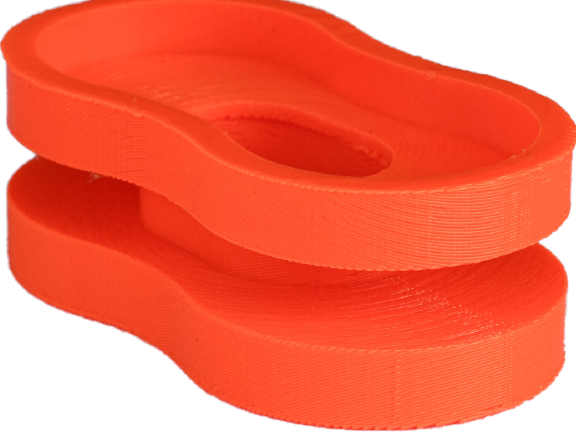
Figure 23. Part with a combination of inward and outside